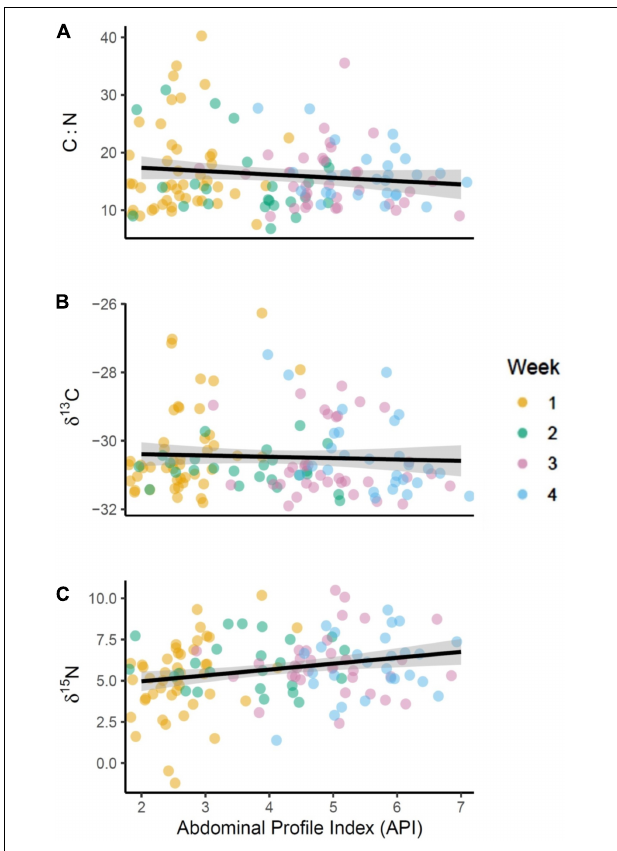
FIGURE 3 | Variation in stable isotope measures (A) C:N ratio, (B) δ 13 C, and (C) δ 15 N associated with weight gain by brent geese during spring staging in Álftanes, Iceland (03/05/2017–27/05/2017). Weight gain measured according to abdominal profile index (API). Data displayed by the week of spring staging when the faecal sample was collected, orange (week 1), green (week 2), purple (week 3), and blue (week 4). Linear regression with standard error (grey shading). An increase in API had a significantly negative effect on C:N ratio ( χ 2 1 = 0.85, p = 0.039, r 2 = 0.28) and no significant effect on δ 13 C ( p = 0.36, r 2 = 0.37). The δ 15 N values were significantly influenced by an interaction between staging week and API ( χ 2 1 = 8.10, p = 0.044, r 2 =